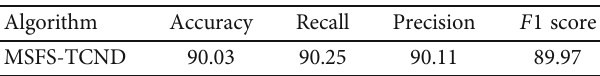
Figure 16: Number of successes and failures in online gesture recognition. Table 7: Average accuracy (%) of 10-gesture recognition by applying MSFS-TCND